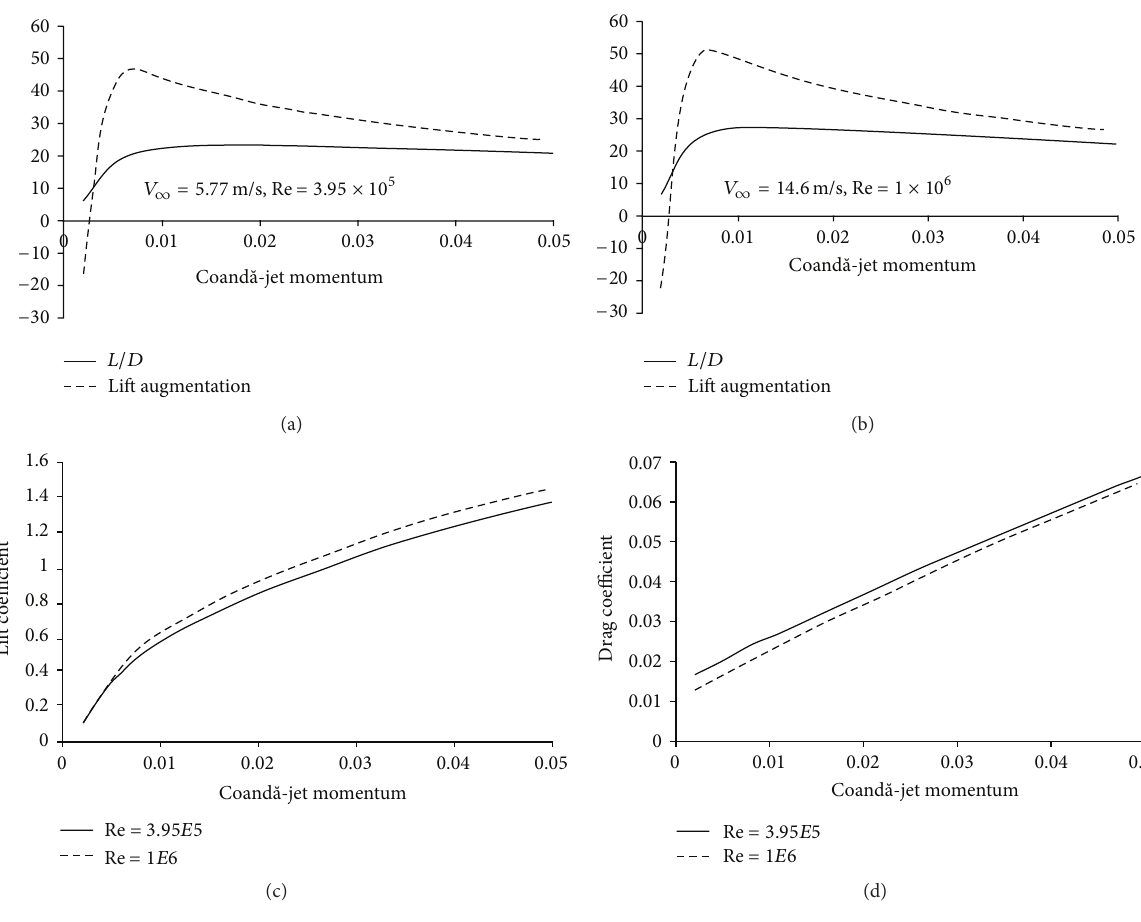
Figure 12: The effect of jet momentum on the L / D and lift augmentation ( 𝑅